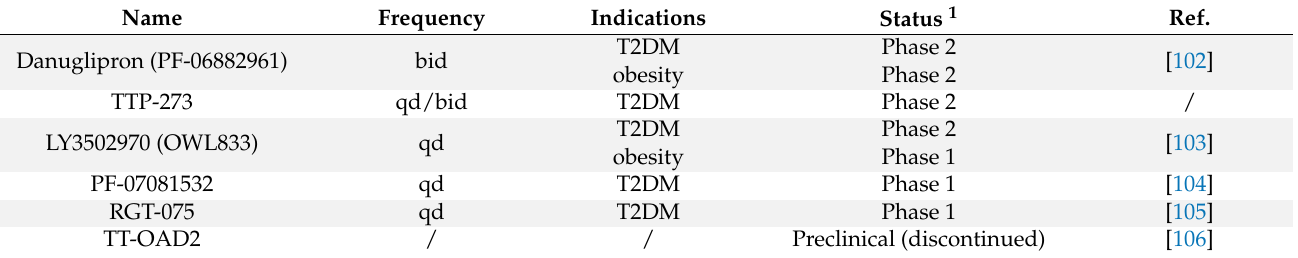
Table 3. Small molecule agonists and PAM targeting